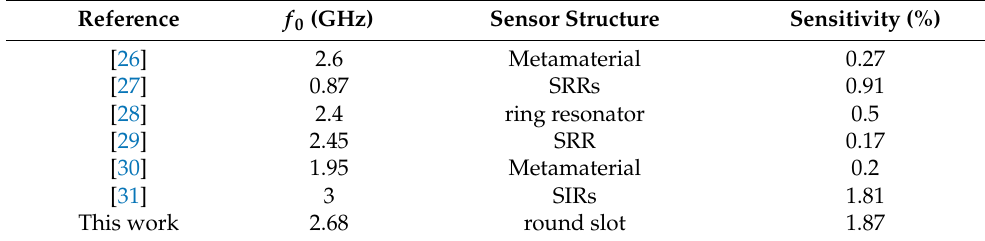
Table 2. Comparison of the sensitivity of this sensor with other sensors for measuring